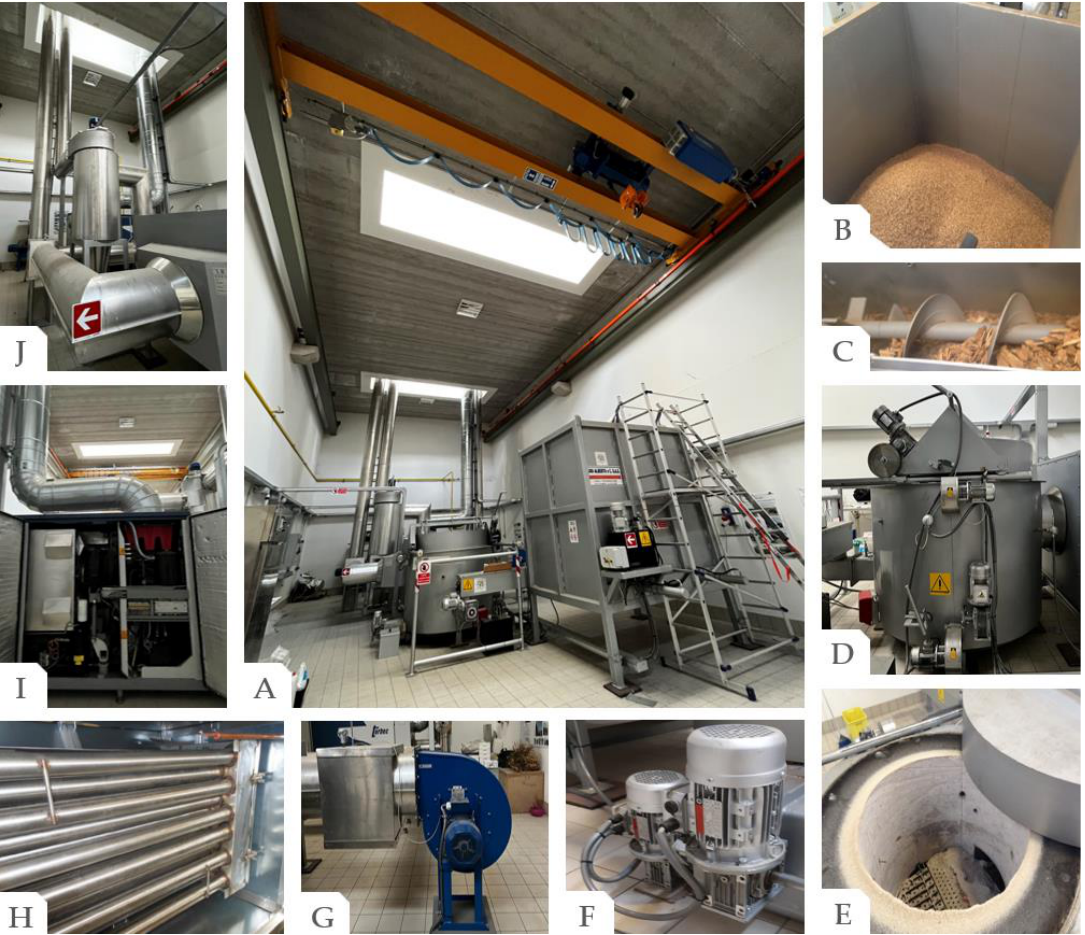
Figure 2. Polygeneration plant facilities: ( A ) polygeneration plant, ( B ) hopper, ( C ) screw conveyor, ( D ) combustion chamber, ( E ) combustion chamber interior, ( F ) combustion chamber rake engines, ( G ) compressor ring engine, ( H ) heat exchanger 1 tubular beam, ( I ) Turbec T100 turbine, and ( J ) cyclone.